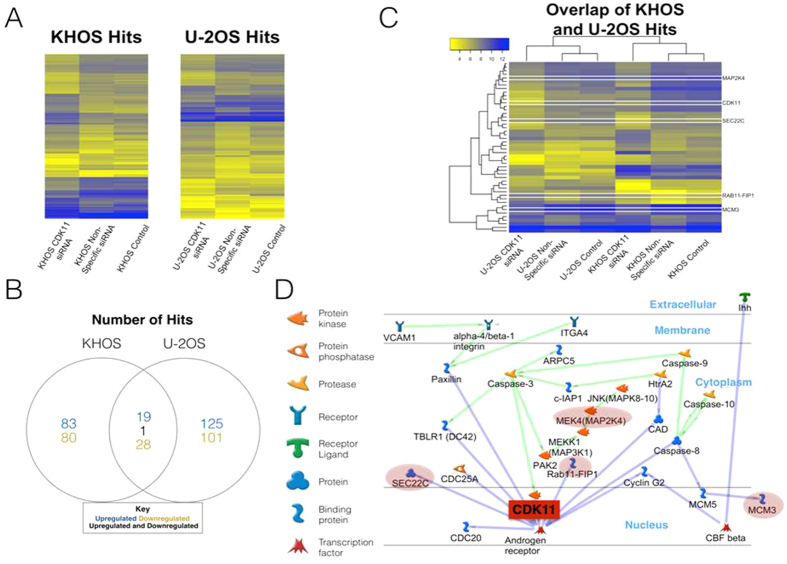
Differential gene expression in KHOS and U-2OS when CDK11 is knocked down and identification of CDK11 and Androgen Receptor gene network as central in osteosarcoma.(A) Heatmap of gene probes significantly perturbed in KHOS and U-2OS upon CDK11 knockdown. (B) Venn diagram showing the gene number breakdown of differentially expressed genes. (C) Heatmap and hierarchal clustering of the common differentially expressed genes in both KHOS and U-2OS. (D) Gene network reconstruction utilizing GeneGo. The common differentially expressed genes were used to seed network reconstruction. Two gene networks, both containing CDK11, were merged (green and blue) and trimmed for irrelevant nodes. The genes highlighted in a red shadow were perturbed upon CDK11 knockdown. The Androgen Receptor (AR) is highlighted as a central node and potentially a significant player.